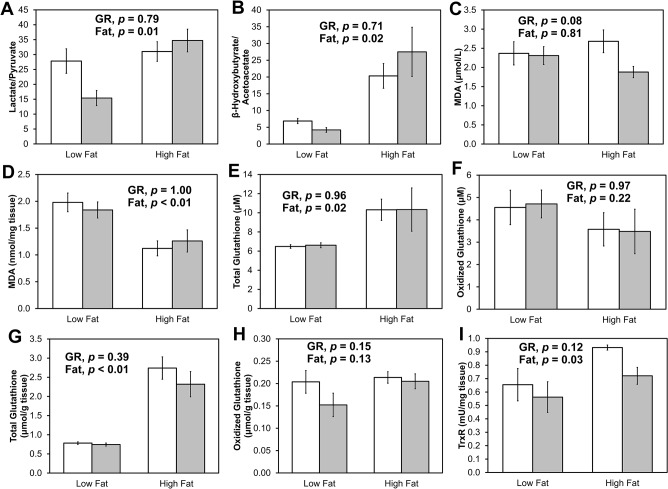

Ex vivo redox measures.At the termination of the study, blood and liver were harvested for redox analysis. Mice that were on the low glycemic response diet are in white and those on the high glycemic response diet are in gray. Mice that were terminated during the 16th week are labeled “Low Fat” while those subjected to the high fat diet for 4 weeks succeeding the low fat leg are labeled “High Fat”. Data represent avg ± SE. A) Lactate/Pyruvate ratio; B) βOHB/Acoc ratio; C) TBARS- blood; D) TBARS- liver; E) Total glutathione- blood; F) Oxidized glutathione- blood; G) Total glutathione- liver; H) Oxidized glutathione- liver; I) Thioredoxin reductase activity in liver.